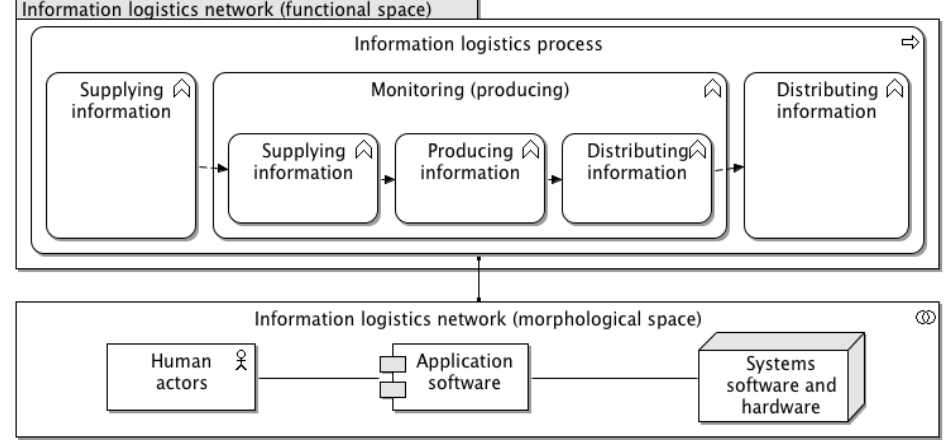
Figure 2. Monitoring node as a nested information logistics network (functional space of representation) and information logistics in the morphological space of representation.